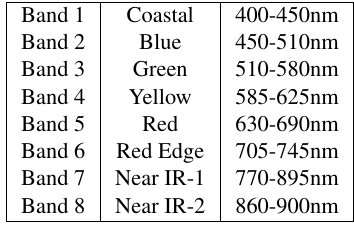
Table 1: Spectral ranges in WorldView-2 sensor